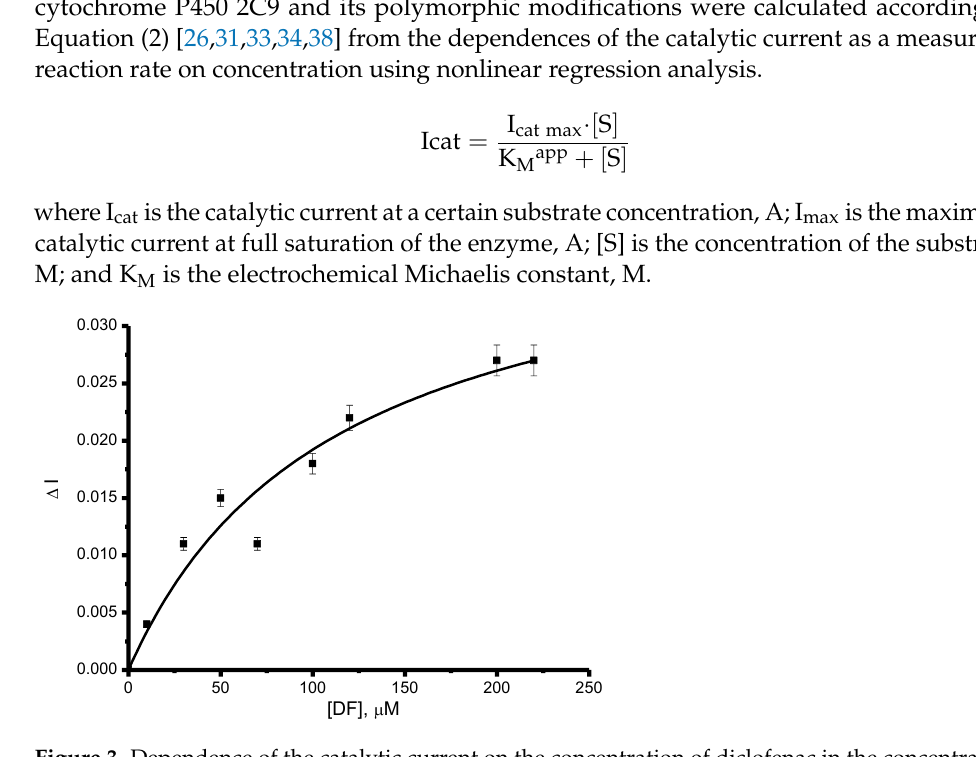
Figure 3. Dependence of the catalytic current on the concentration of diclofenac in the concentration range of 10–200 µ M for SPE/DDAB/P450 2C9, applied potential of electrolysis is E = − 0.55 V. The Michaelis constants K M of diclofenac for cytochromes P450 2C9, P450 2C9*2,